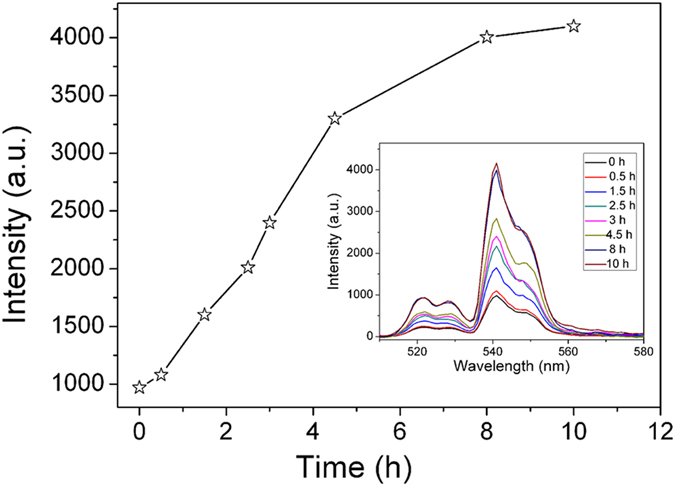
UC emission intensity of UCNPs@SiO2@PMAA nanocomposite as a function of release time.